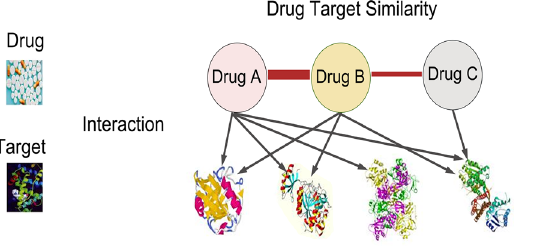
Fig 3. In order to calculate the similarity between two drugs, we extract the information from drug- target interactions. The underlying assumption made here is that two drugs that share more common target proteins are more